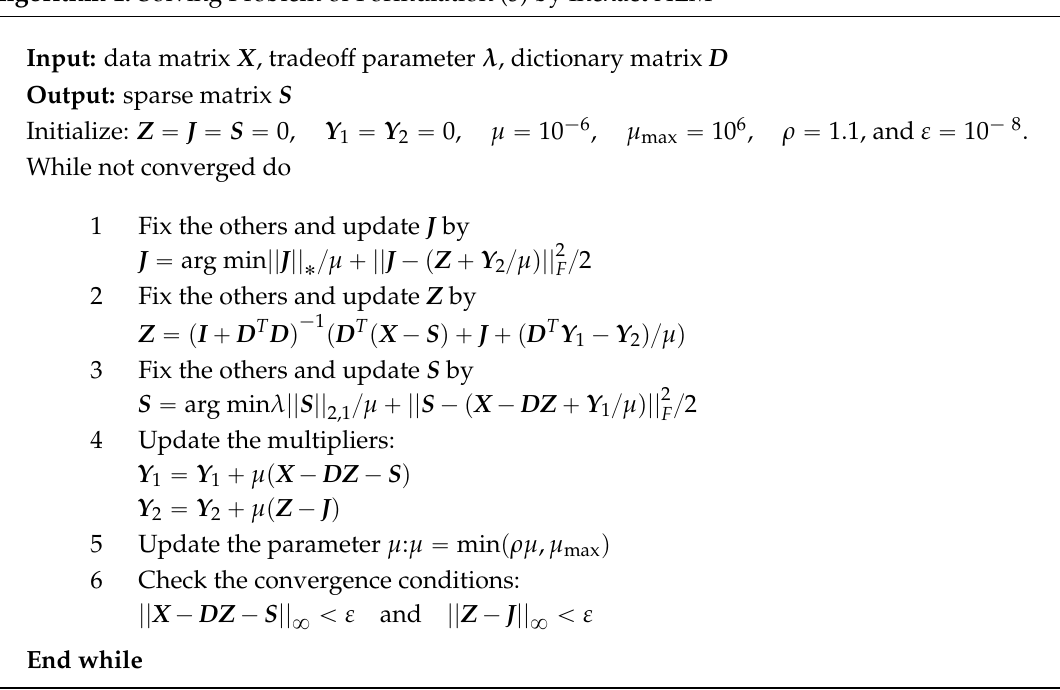
Algorithm 1. Solving Problem of Formulation (5) by Inexact